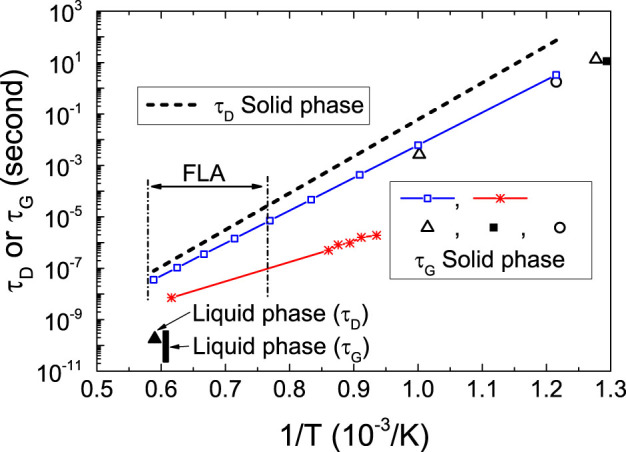
Competition between the Si recrystallization and selenium diffusion characterized by the time needed to regrow (τG) or diffuse (τD) one monolayer.The dashed line is τD in solid phase according to the diffusion parameter in Ref. 45. The other lines or symbols are τG according to different references: open square46, star47, open triangle48, solid square49, open circle20. Despite the possible uncertainty of the regrowth velocity, τG is smaller than τD. That means it is possible to trap selenium and realize metastable, selenium over-saturated Si layer. The vertical dashed and dotted lines indicate the working regime of flash lamp annealing (FLA). The reported τG is shown as a solid triangle2 and τD is shown as a vertical thick line by assuming the growth velocity of 1–10 m/s for pulsed laser annealing (PLA).